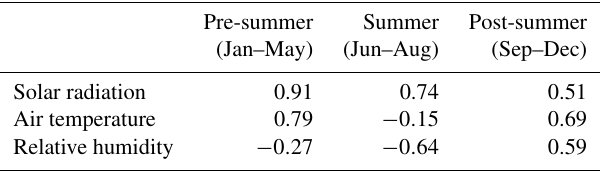
Table 1. Same as Fig. 2, but for correlation coefficients between ozone and meteorological variables for pre-summer, summer, and post-summer